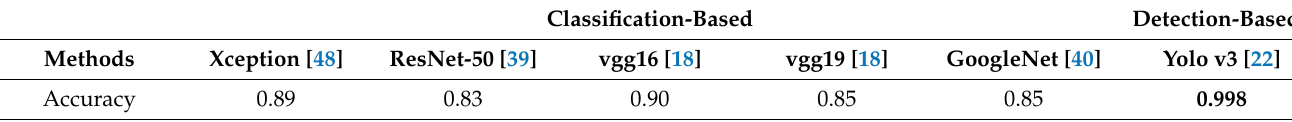
Table 7. Performance comparison of PCB parts : MCU dataset.